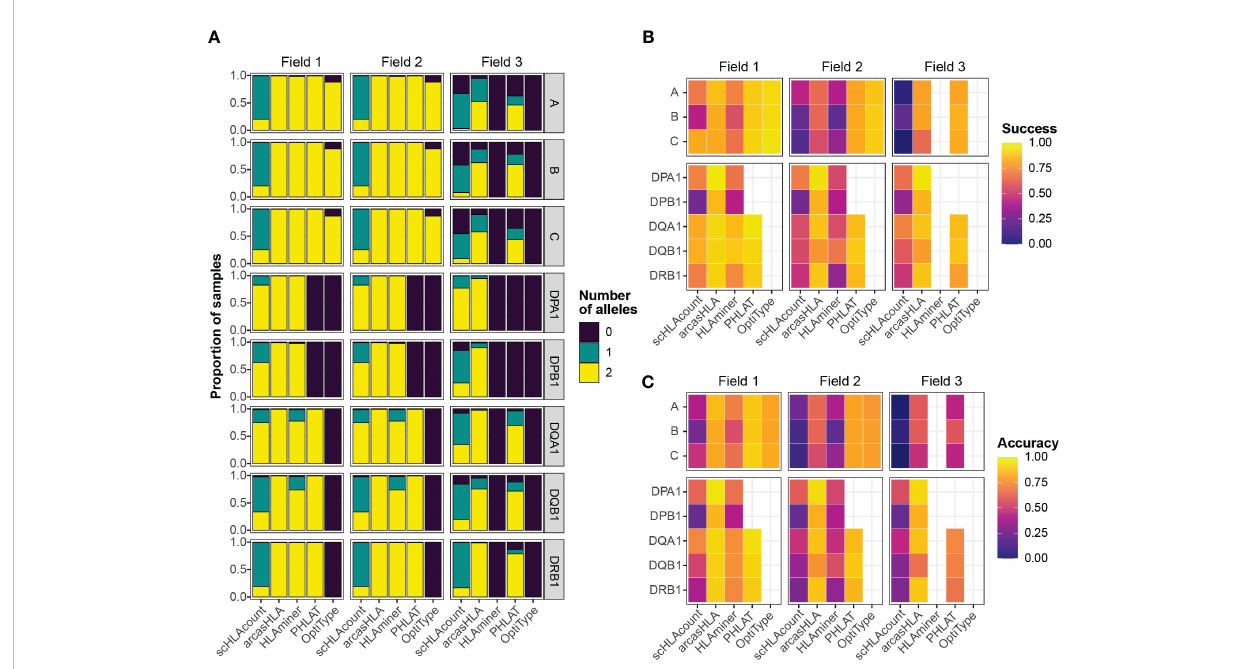
FIGURE 2 Accuracy of HLA genotype predictions (A) Relative proportion of samples with 0, 1, or 2 allele predictions. (B) Mean success and (C) mean accuracy of predicted genotypes compared to molecular genotyping. Empty heatmap tiles represent genotype parameters not assessed by a given